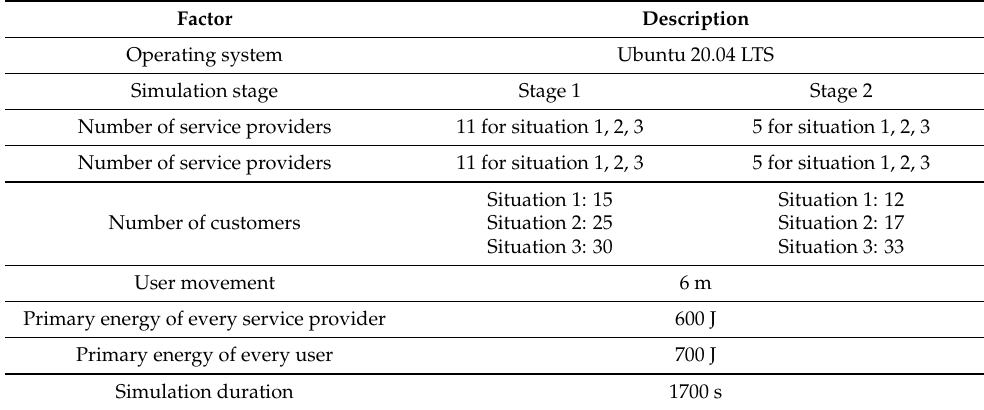
Table 3. Factors considered for simulation in